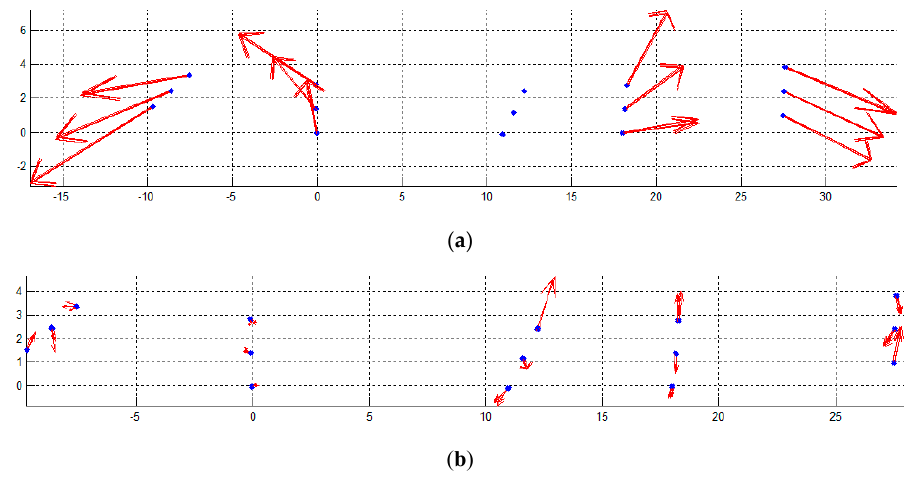
Figure 13. Spatial residuals in meters in the XY plane for the rigid transformation from underwater to the above the water coordinate systems without scale factor ( a ) and with the alignment through independent model adjustment ( b ). Vector length exaggeration factor: 1000.